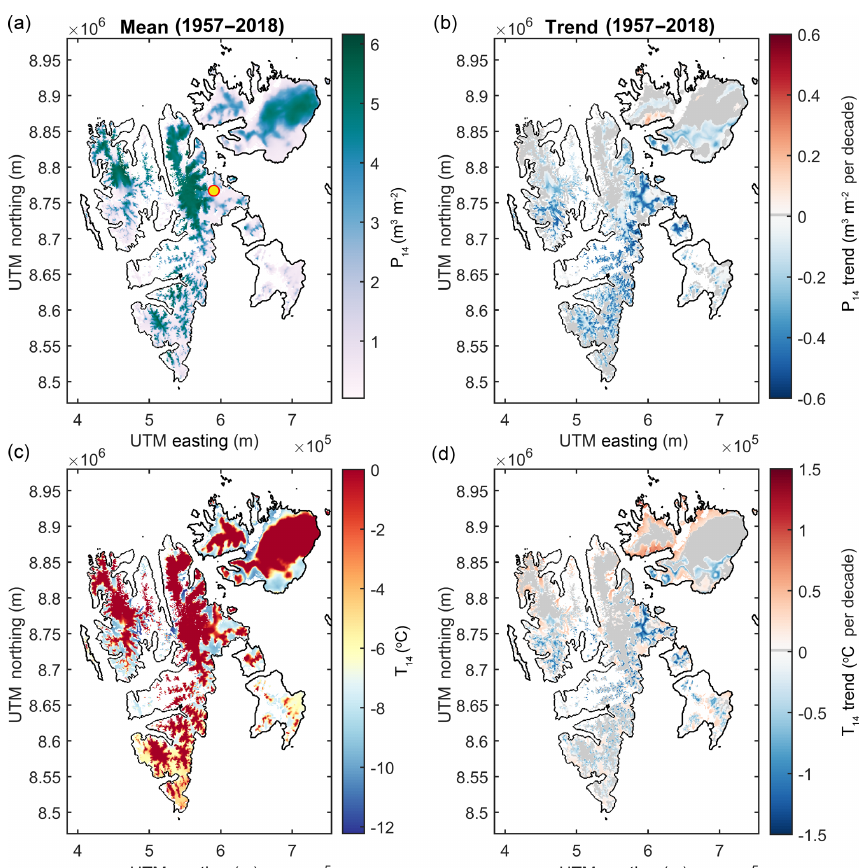
Figure 7. Long-term mean P 14 distribution (a) and trends (b) . Long-term mean T 14 distribution (c) and trends (d) . The corresponding location of the subsurface profiles in Fig. 8 is marked with a red circle in (a)